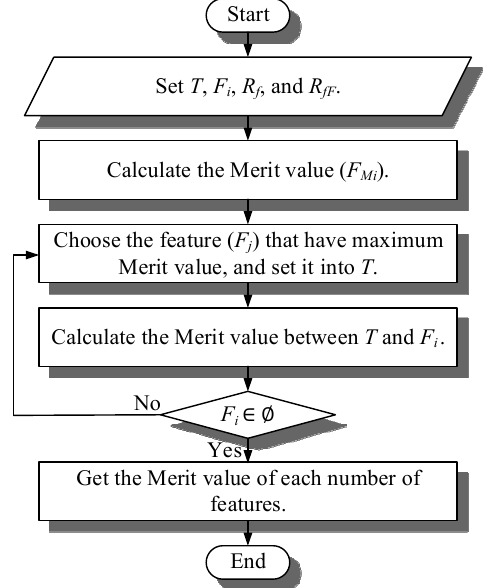
Figure 9. Flowchart of the correlation-based feature selection (CFS).